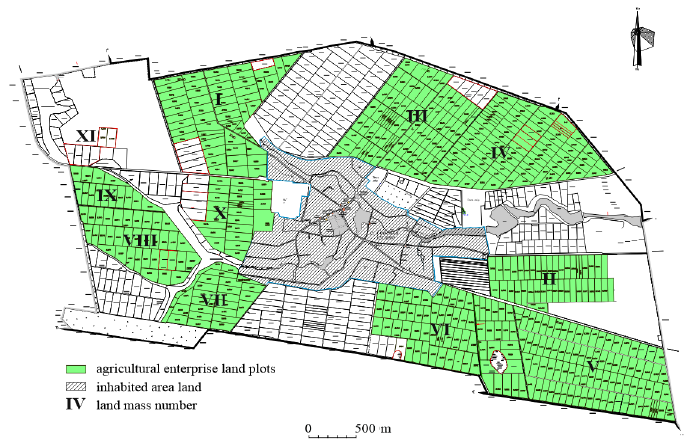
Figure 11. Land consolidation through land plots exchange (option ІІ)